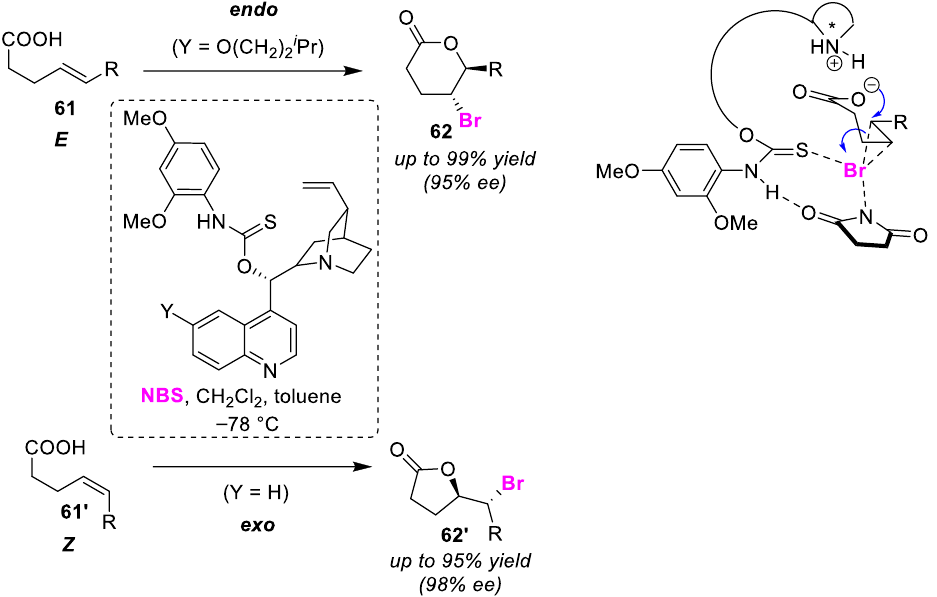
Figure 30. Endo / exo selective bromo-lactonizations of monosubstituted E -olefinic and Z -olefinic acids ( 61 and 6 1′ ) using an amino-thiocarbamate catalyst.